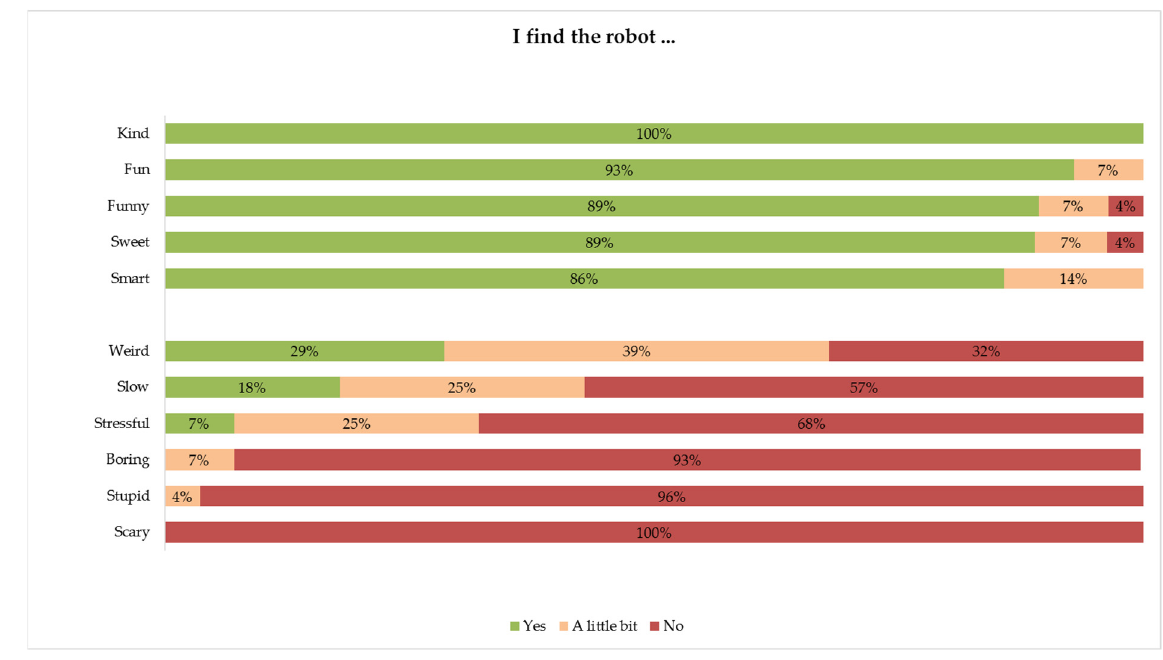
Figure 4. Ratings of the robot by children.